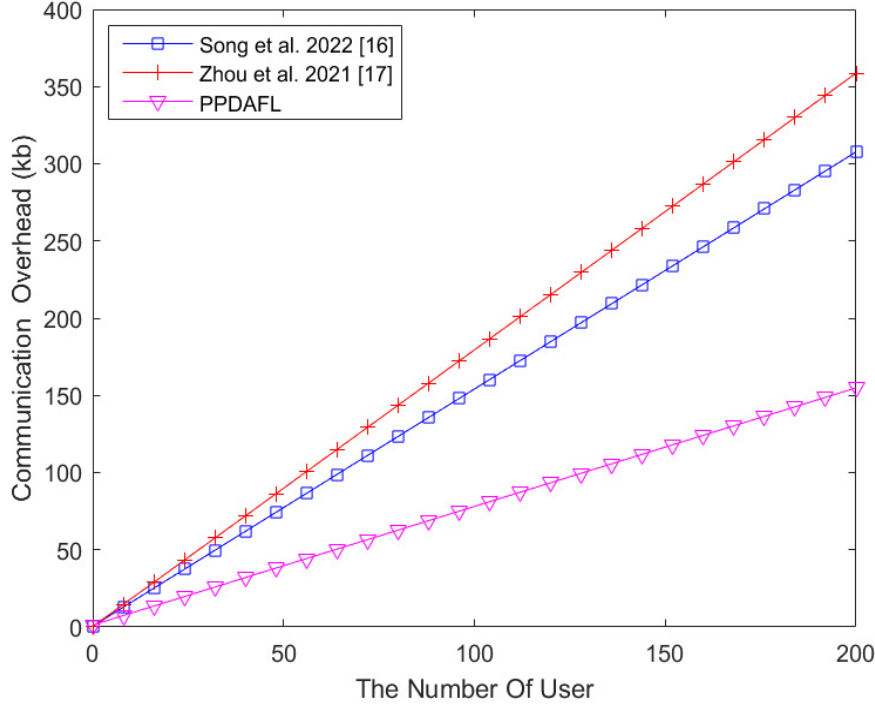
Figure 5. Comparison of communication overhead when 𝑅 = 256 bits [16,17].